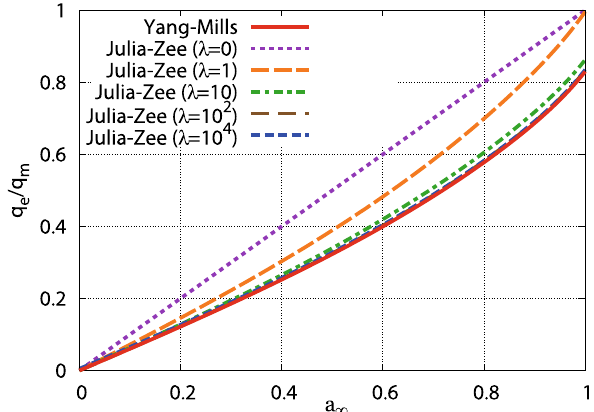
Fig. 4 The a ∞ dependence of the ratio q e / q m between two charges q e , q m , namely C . Throughout in this paper, we fix the magnetic charge q m to the unit 4 π/ g , which means that C is nothing but the electric charge q